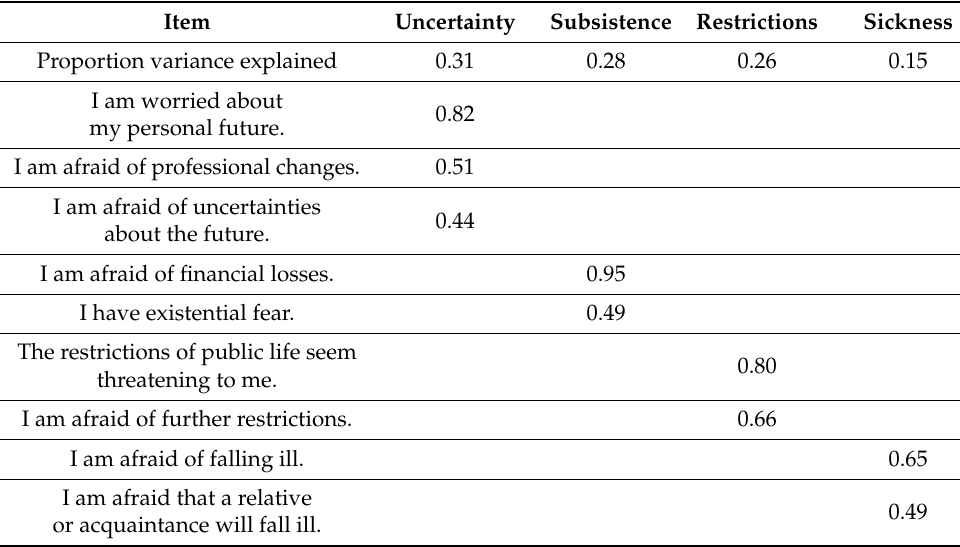
Table 2. Factor solution of the items of the questionnaire on